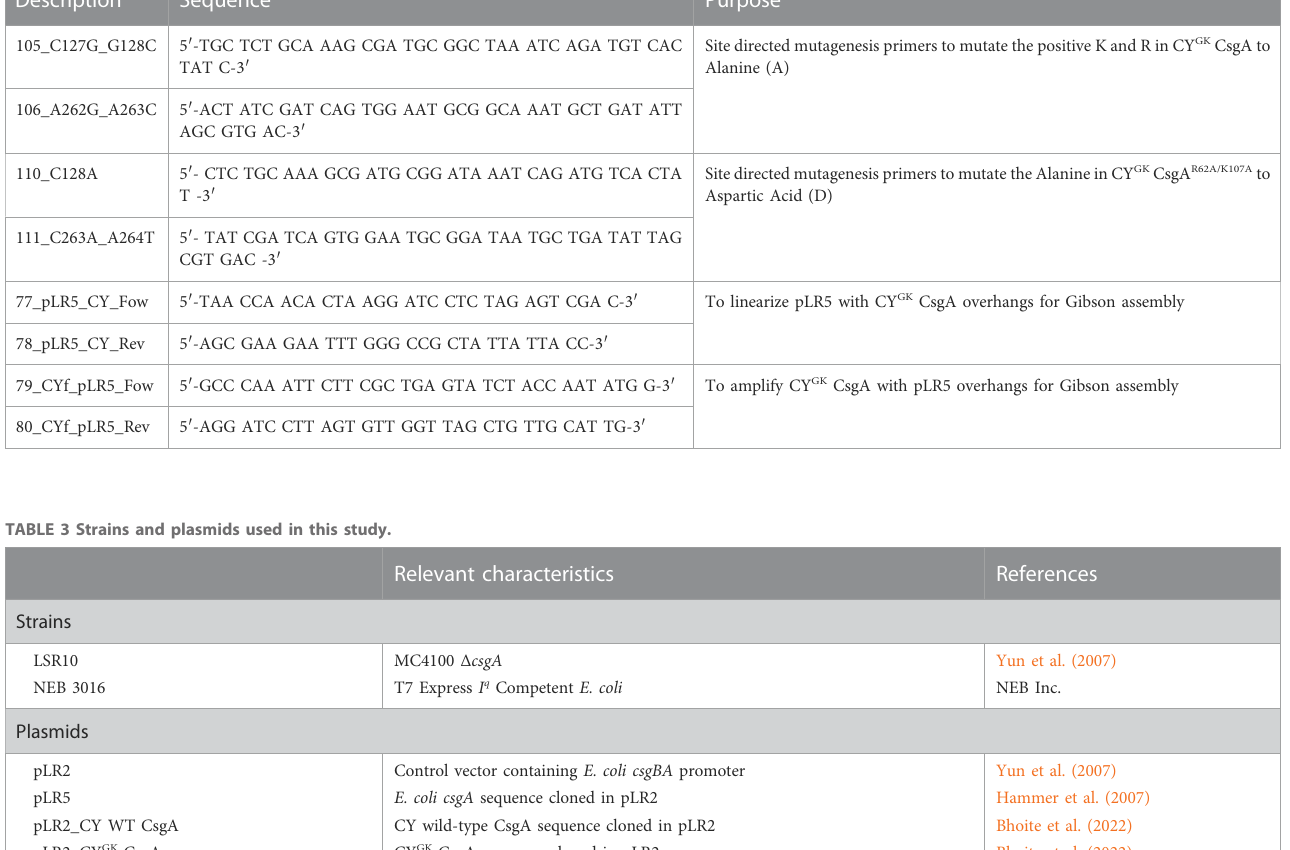
TABLE 2 List of oligonucleotide primers used. Description